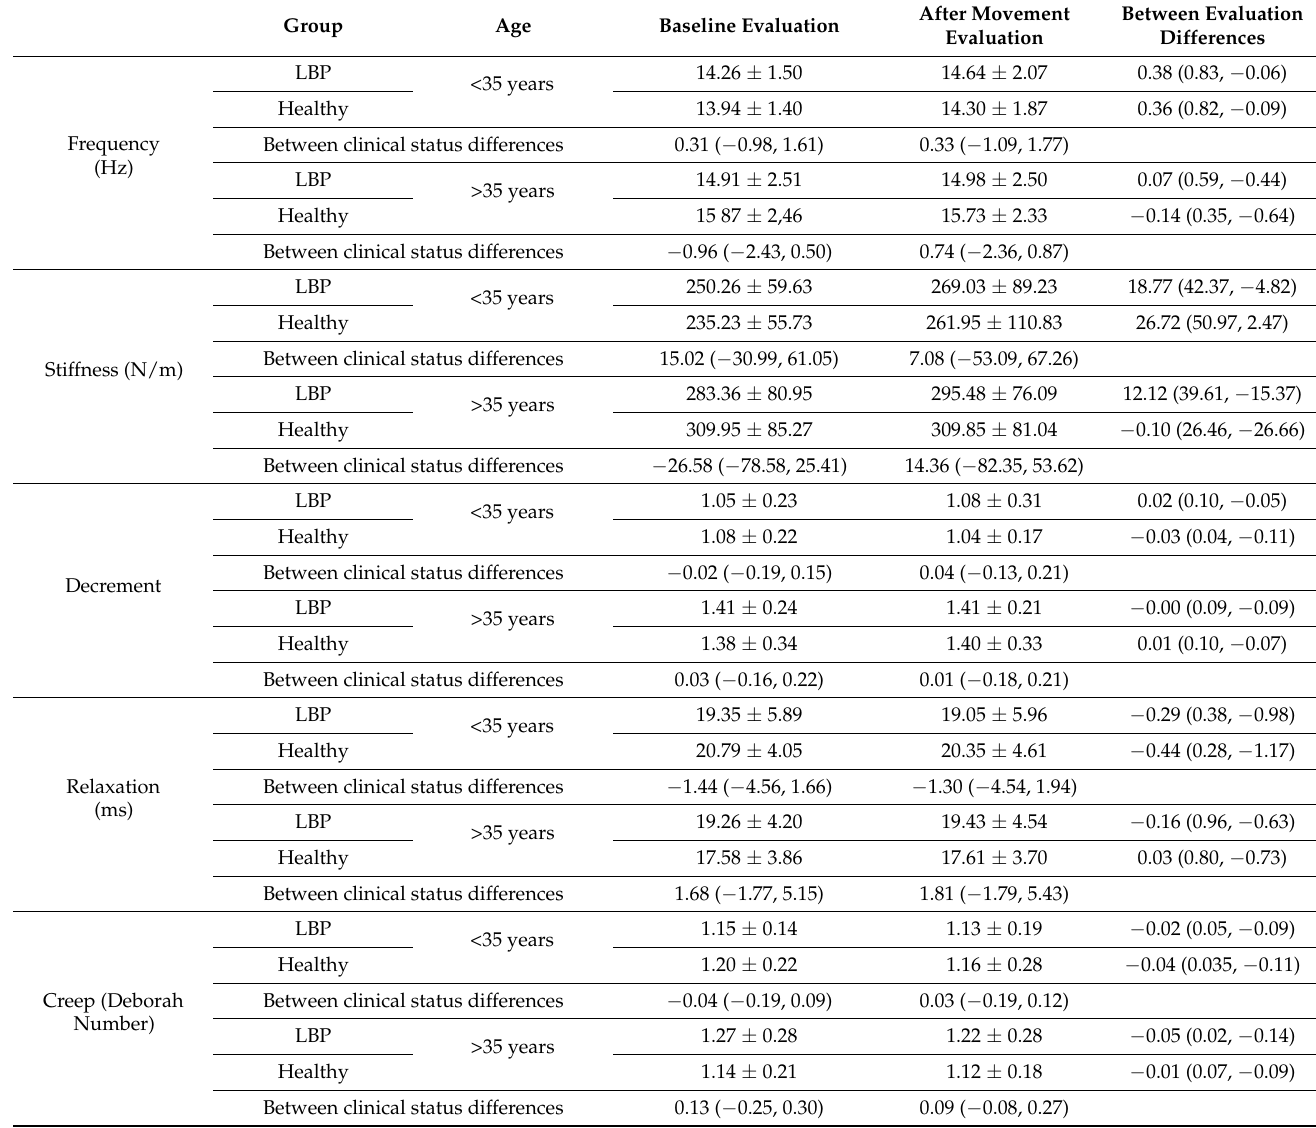
Table 2. Results of MMPs according to the clinical status (LBP group, N = 33; healthy group, N = 33), age, (under 35 years, n = 37; over 35 years, n = 29), and time of assessment. Group Age Baseline Evaluation